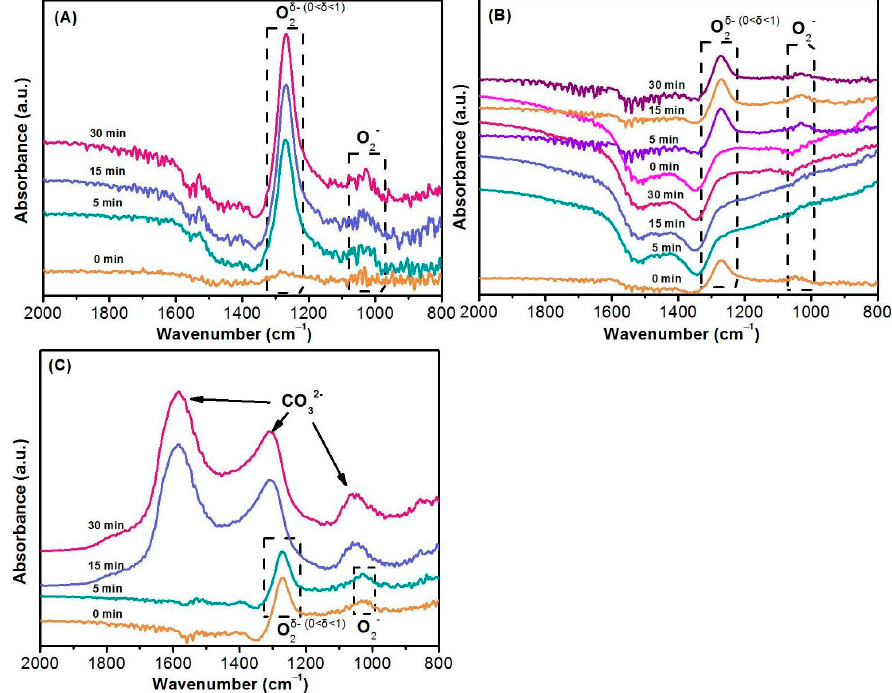
Table 6. Surface oxygen characteristics of the catalysts identified by XPS and O 2 -TPD .